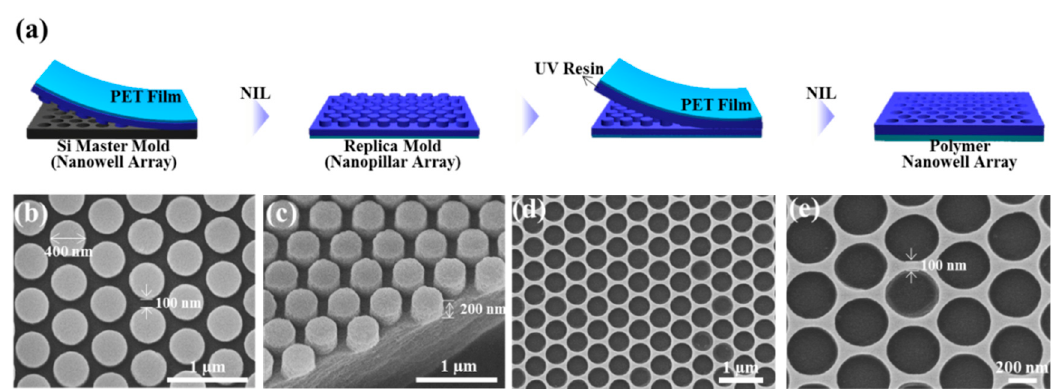
Figure 1. Fabrication of nanowell array. ( a ) Schematic of the fabrication process of the polymer hexagonal nanowell array using nanoimprint lithography (NIL). ( b , c ) Scanning electron microscopy (SEM) images showing the top view and 45°-tilted view of a replica mold with a nanopillar array. ( d , e ) SEM images of polymer nanowell array replicated from the nanopillar soft mold.